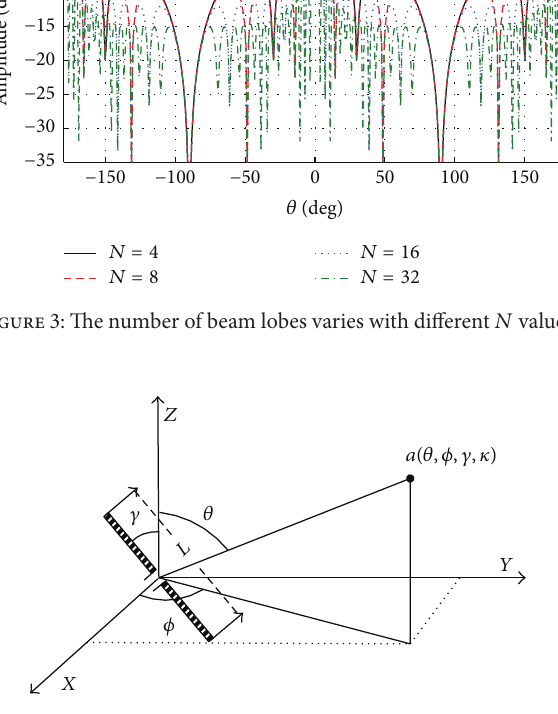
Figure 4: Configuration of the dipole